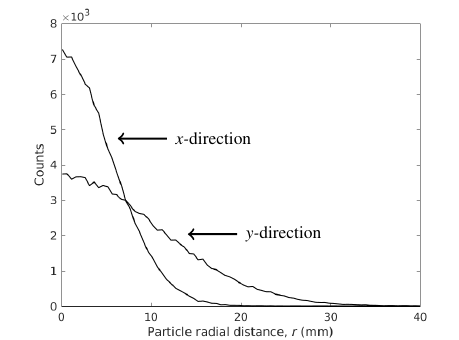
Figure 1. Radial intensity profile in the x- and y- direction for 70MeV carbon ion beam at 150mm in air through a 10 µ m My- lar.